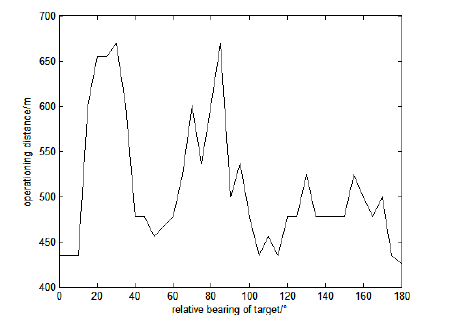
Fig. 2. Operationing distance of active acoustic homing torpedo.